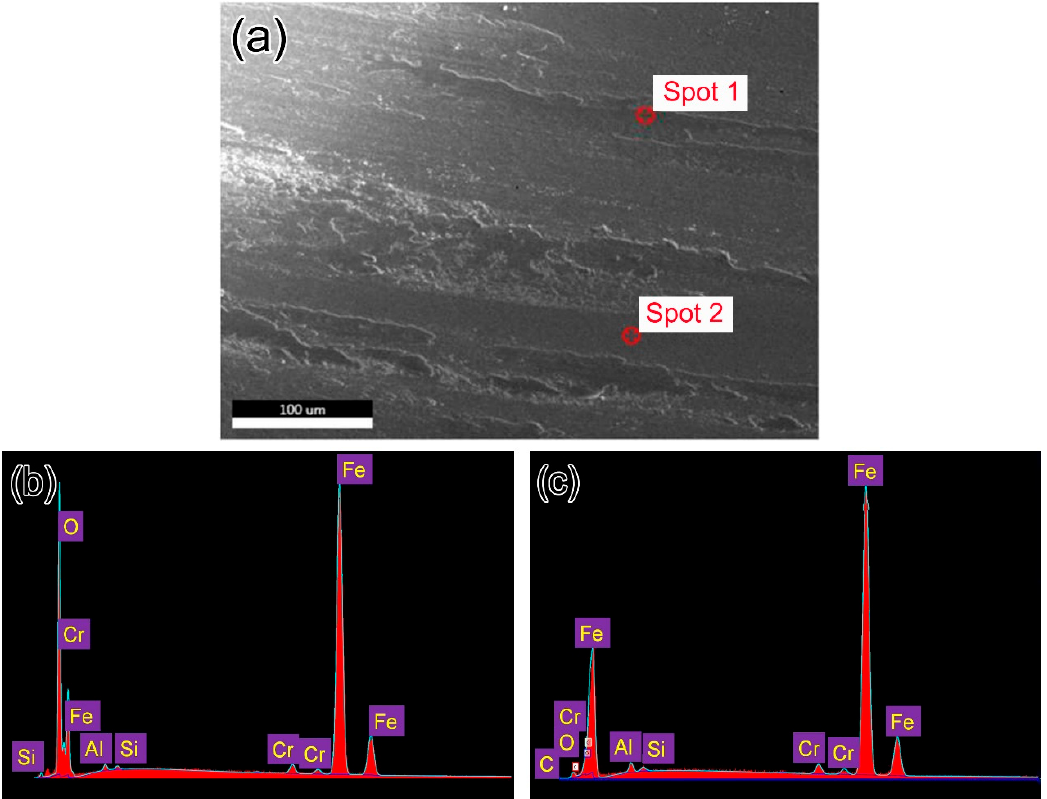
Figure 5. ( a ) SEM images of a typical worn surface of B45 after sliding test under 75 N, ( b ) and ( c ) EDS results corresponding to spot 1 (b) and spot 2 (c) in (a).